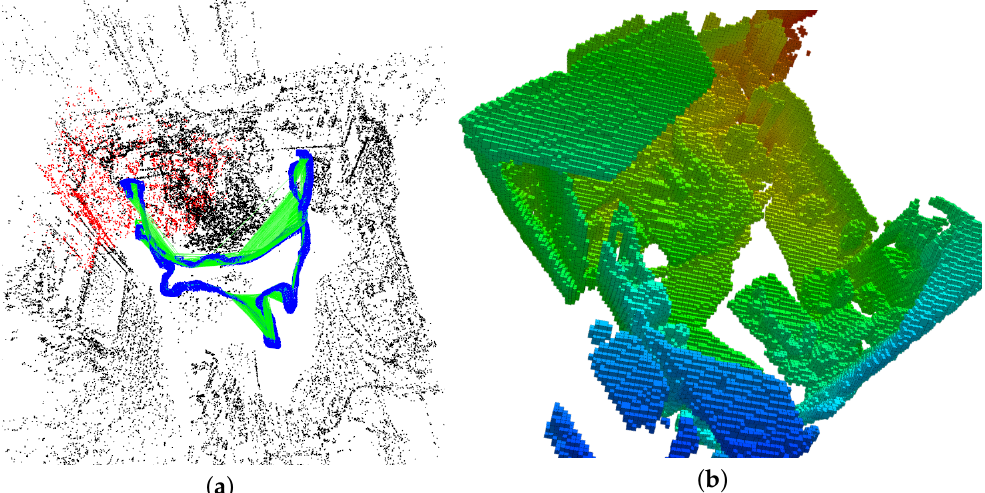
Figure 3. OctoMap representation for fr 1/ room of TUM RGB-D SLAM benchmark [37] with visual SLAM. ( a ) the sparse map from original ORB-SLAM [35], map points ( black , red ), keyframes ( blue ); ( b ) OctoMap